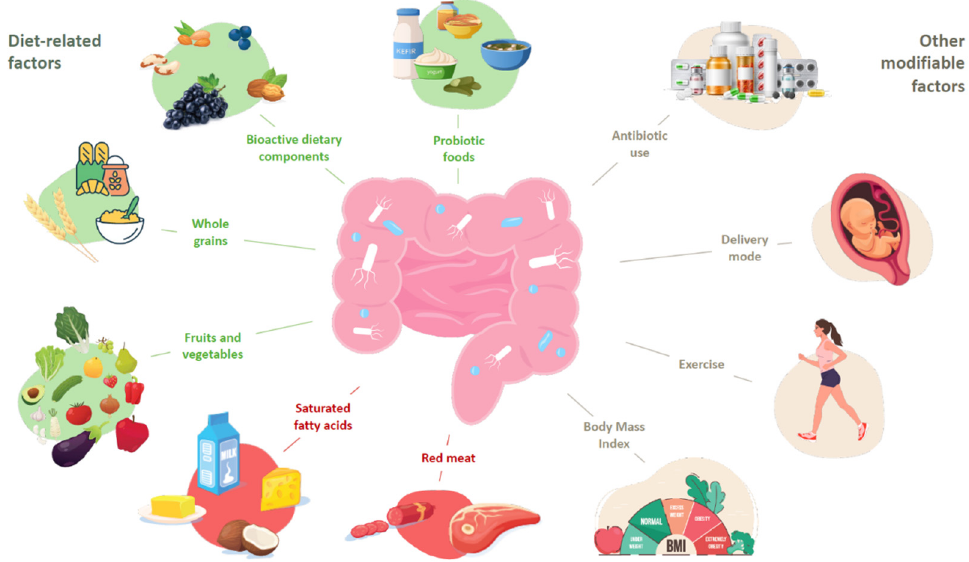
Figure 1. Factors associated with gut microbiota